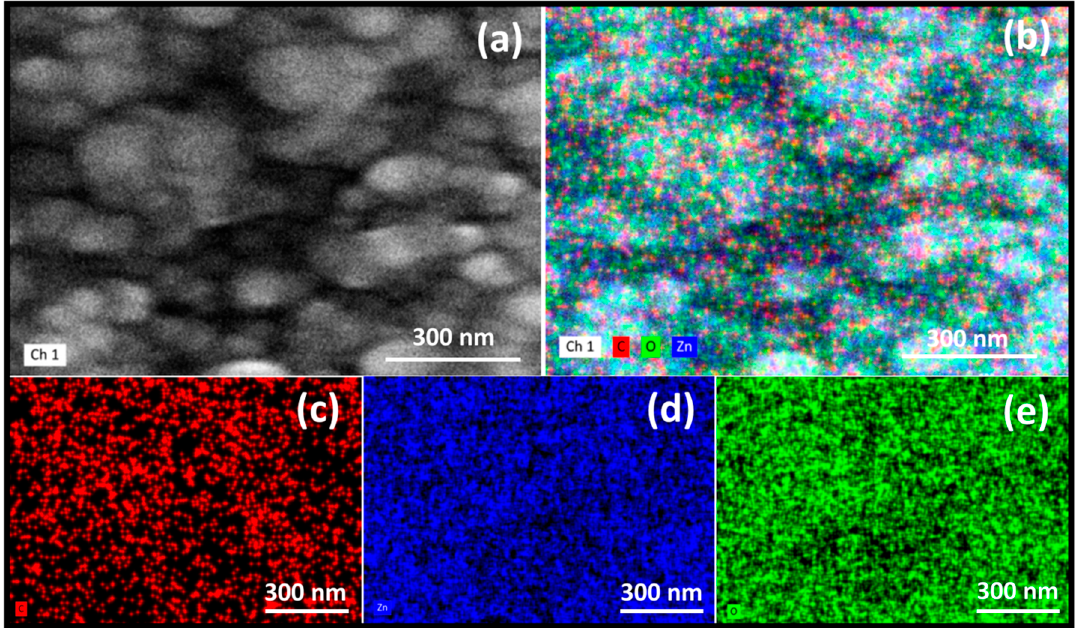
Figure 7. Elemental mapping analysis of a ZnO-rGO_3 thin film: ( a ) specific area, ( b ) C, O and Zn, ( c ) C, ( d ) Zn and ( e ) O.